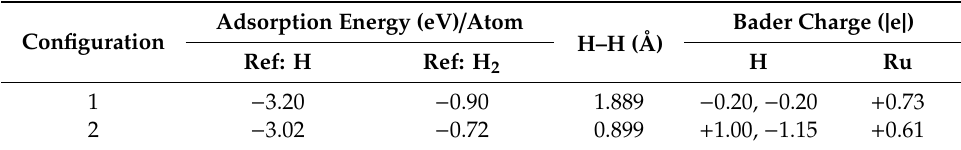
Figure 14. ( a ) Relaxed configuration (configuration 1) of molecular hydrogen adsorbed on the surface of Ru-doped C 60 , ( b ) bond distances (H–H and C–C) in the relaxed configuration and ( c ) charge density plot showing the non-covalent interaction. Similar figures ( d – f ) are shown for configuration 2. Table 8. Calculated adsorption energies with respect to gas phase molecular hydrogen, H-H bond distances and Bader charges on the Ru and H atoms.